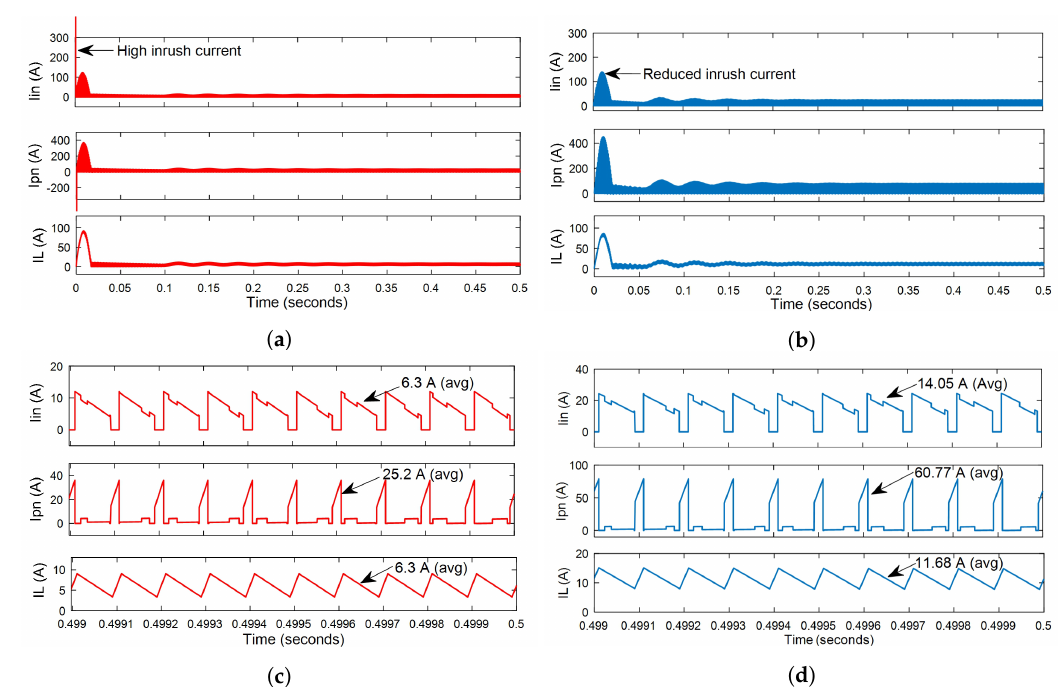
Figure 11. Simulation results (case 1): ( a ) traditional MCA-ZSI. ( b ) Proposed SL-SBZSI. From top to bottom: input current, I in ; shoot-through current; I pn and inductor current, I L 1 . Enlarge waveform: ( c ) Traditional MCA-ZSI. ( d ) Proposed SL-SBZSI. From top to bottom: input current, I in ; shoot-through current; I pn and inductor current, I L 1